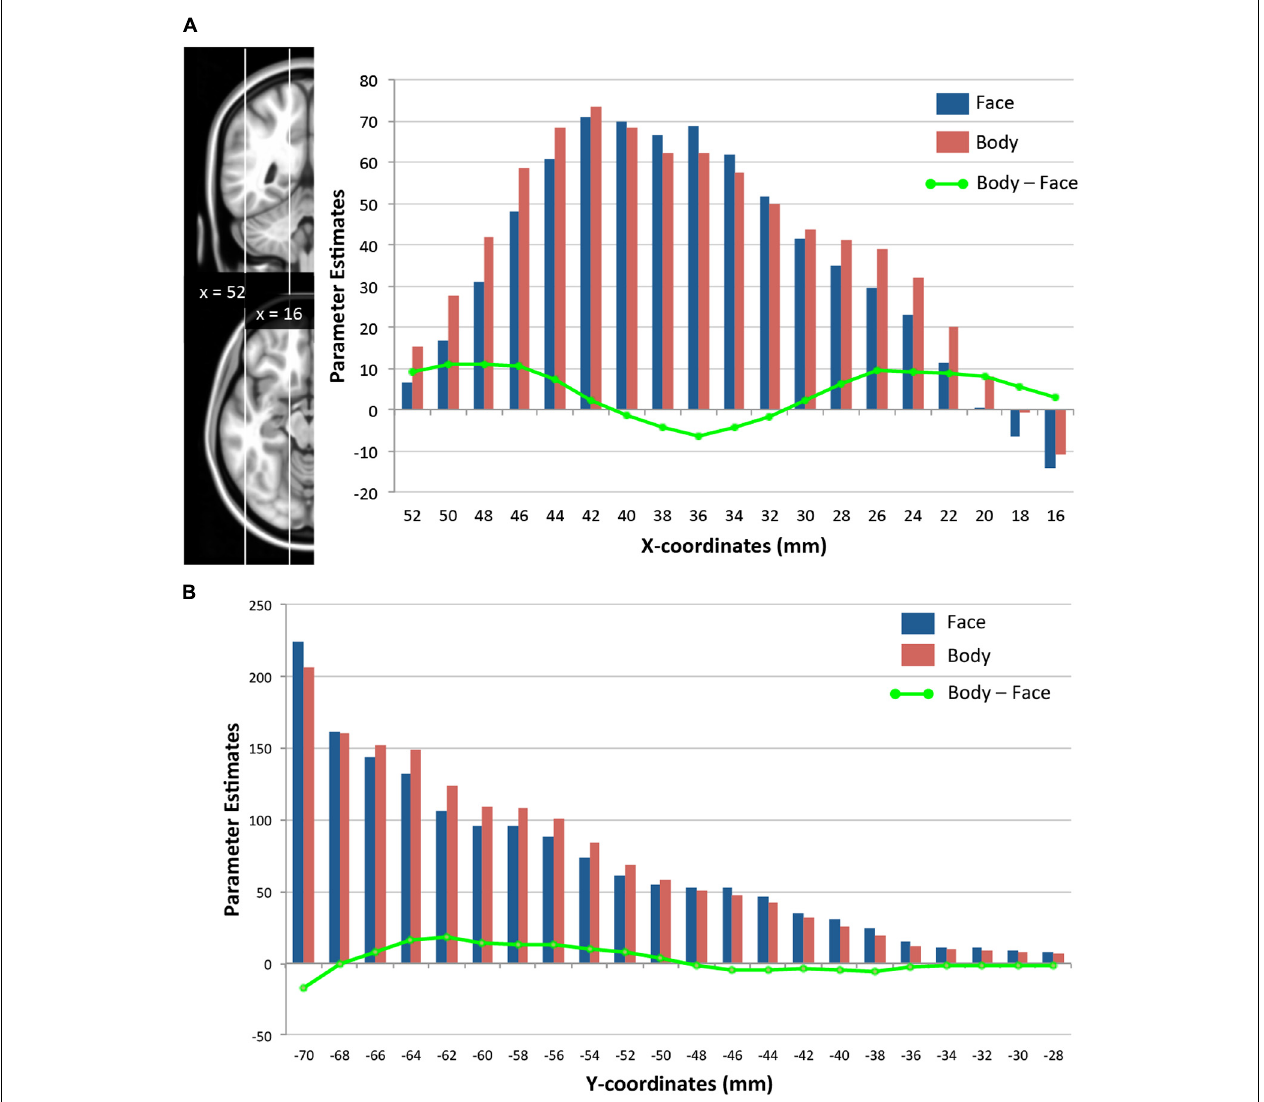
FIGURE 5 | Spatial distributions of face- and body-evoked activity. (A) Magnitude of face- and body-evoked activity (relative to baseline) along the lateral–medial axis (x-axis) within the TOFC ROI at x-coordinates (MNI) from 52 mm (lateral) to 16 mm (medial). (B)